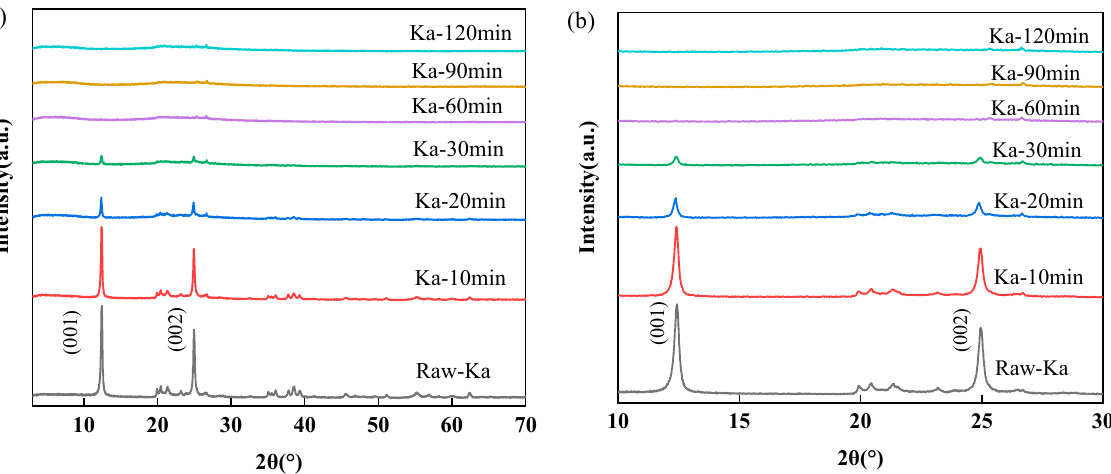
Figure 5. ( a ) XRD patterns of kaolin annealed for different holding times; ( b ) local amplification of kaolin annealed for different holding time, in the range of θ = 10–30°. Figure 6a shows the XRD simulation patterns of Sim-Ka, Phase 1, Phase 2, Phase 3, and Phase 4. Material Studio was used to simulate the XRD pattern and the XRD pattern with the removal of partial hydroxyl and the changes of atomic position that denoted Phase 1, Phase 2, Phase 3, and Phase 4. With the removal of the partial hydroxyl and the change of Si atom position, it can be observed that the diffraction peak changes significantly. The θ m moves from 12.25° to 11.79°, and the peak intensity in the range of 2 θ = 20–30° is no longer consistent with the intensity shown in PDF 78–2110, while certain peaks with a smaller intensity have appeared. The details are shown in Figure 6b. The spectrum shows an amorphous structure with crystalline peaks of kaolinite, suggesting incomplete dehydroxylation compared with the spectrum shown in Figure 5 and in previous studies [11,17].